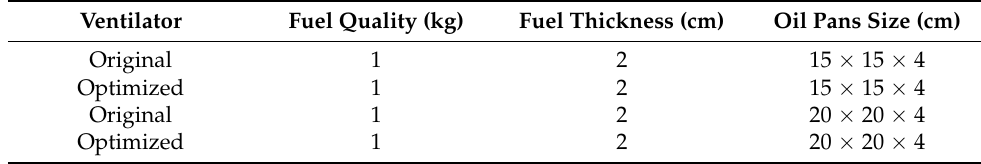
Table 8. Experimental conditions in the smoke exhaust experiments.